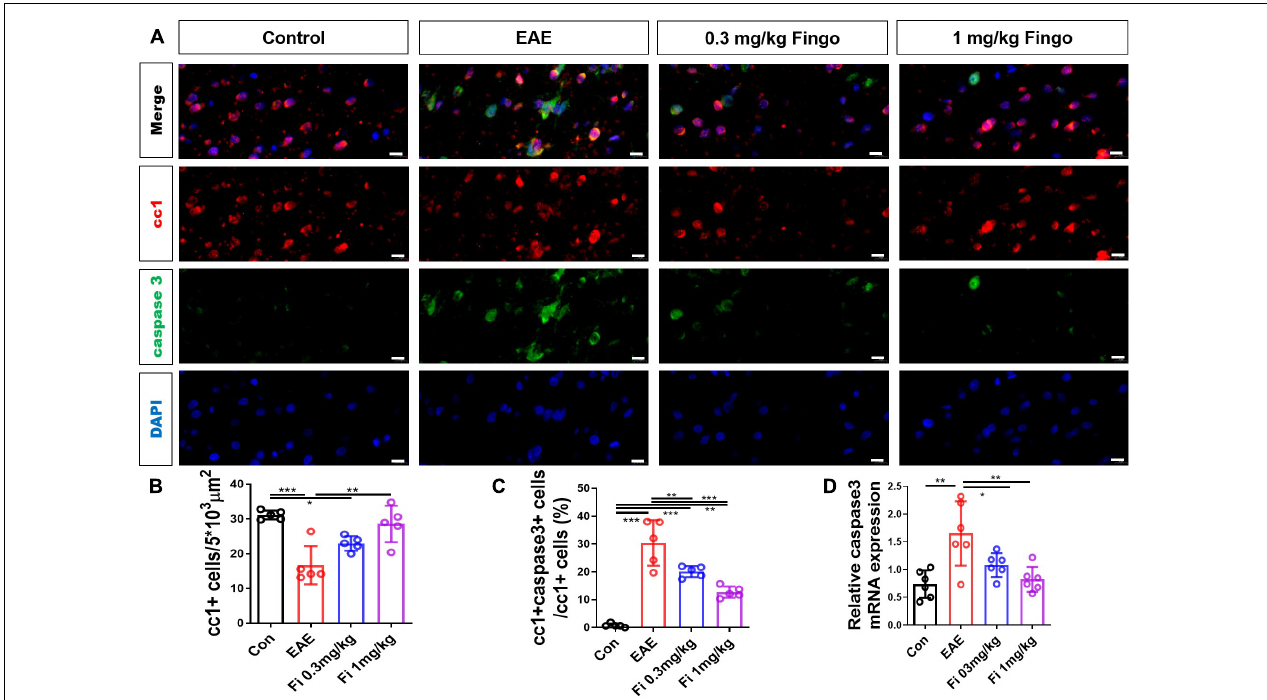
FIGURE 4 | Oligodendrocyte apoptosis with fingolimod treatment. (A) Oligodendrocytes and apoptotic cells in the optic nerve were marked with cc1 and cleaved caspase 3; the apoptotic oligodendrocytes were labeled both. (B) Number of cc1+ cells in the optic nerve (area = 5 × 10 3 µ m 2 ). (C) Ratios of cc1+ cleaved caspase 3+ to cc1+ cells in the optic nerve. (D) Caspase 3 mRNA expression in optic nerve. Values are represented as mean ± SD. One-way ANOVA plus Tukey’s multiple comparisons. * P < 0.05, ** P < 0.01, *** P < 0.001. Scale bar = 10 µ